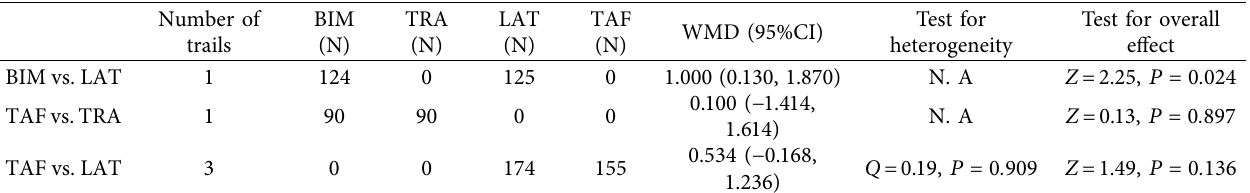
Table 5: Efficacy of PGAs in OAG/OHT